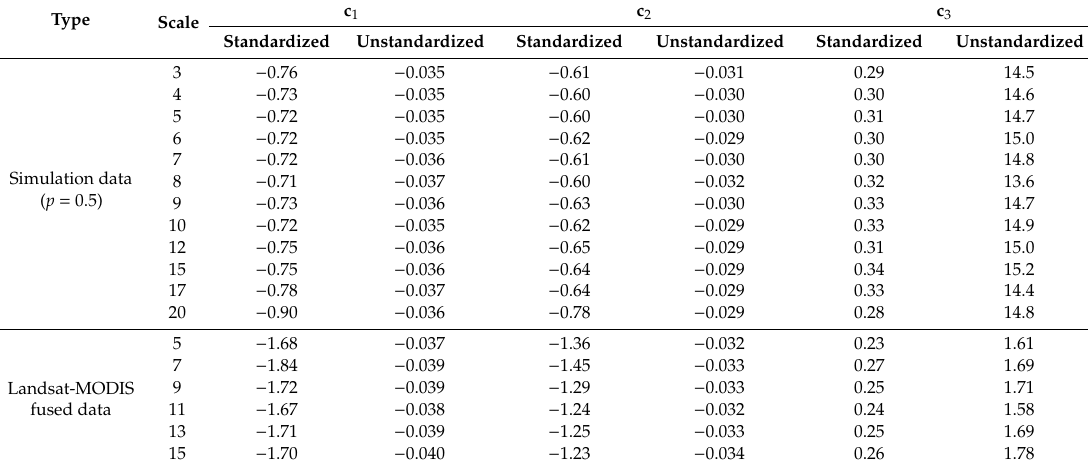
Table 2. The model coe ffi cients (c 1 , c 2 , c 3 ) in simulation data (taking p = 0.5 as an example) and Landsat-MODIS fused EVI2 data. Scale refers to the size of the aggregated window. Type Standardized Unstandardized Standardized Unstandardized Standardized Unstandardized